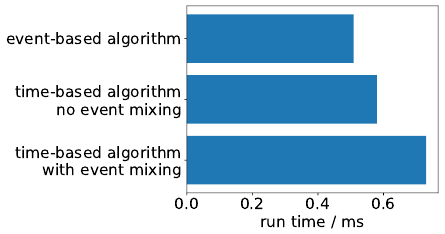
Figure 3: Performance of di ff erent implemen- tations of the cellular automaton track